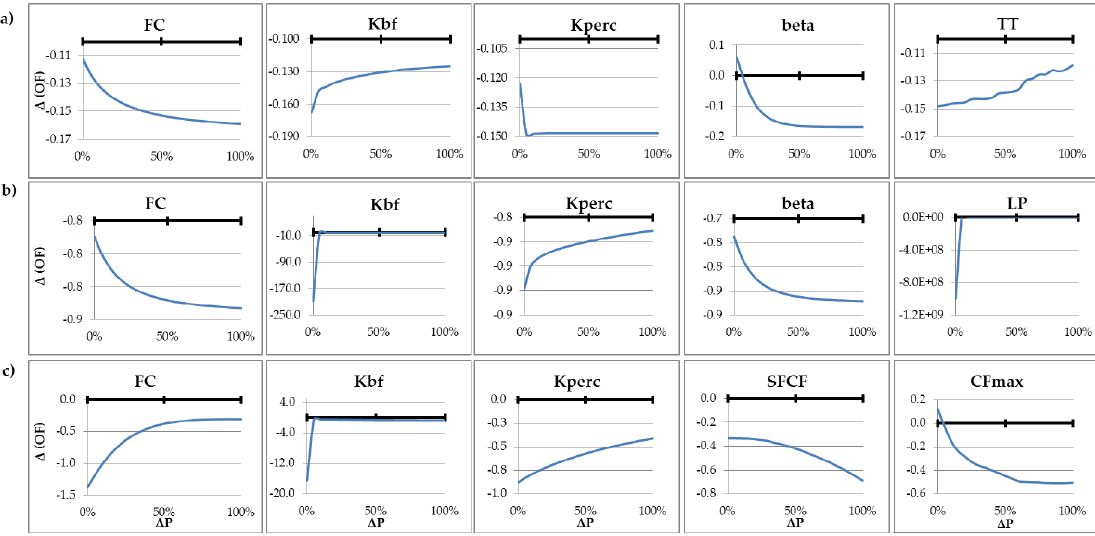
Figure 6. Comparison of clustering validity index by ( a ) Partition Index (SC) and ( b ) Separation Index (S).